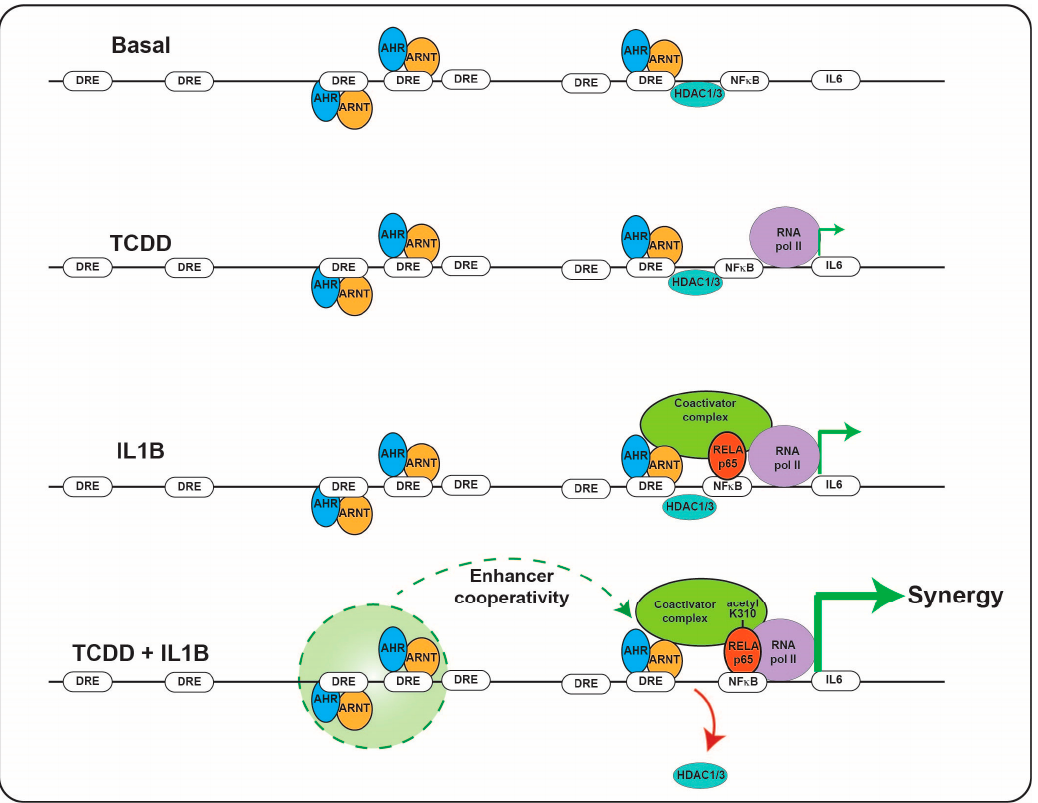
Figure 2. Combinatorial regulation of IL6 promoter by the AHR and NFkB. The presence of AHR / ARNT and NFkB on the IL6 promoter results in HDAC1 / 3 dismissal and subsequent hyperacetylation of NFkB resulting in synergistic induction of IL6 transcription.